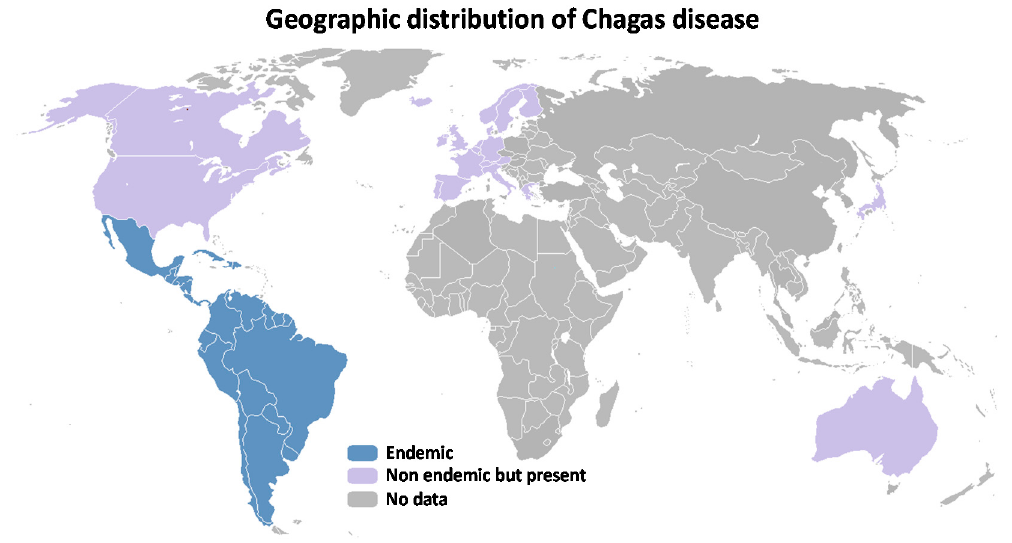
Figure 1. Global distribution showing the countries endemic for Chagas disease, where transmission occurs mainly through insect vector action, as well as the countries that receive infected people from these regions due to the migratory process